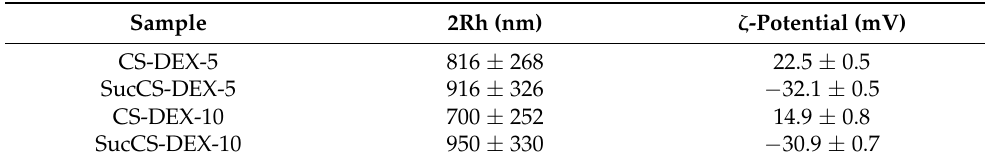
Table 3. Physicochemical characteristics of CS-DEX and SucCS-DEX (mean ± standard deviation, n =